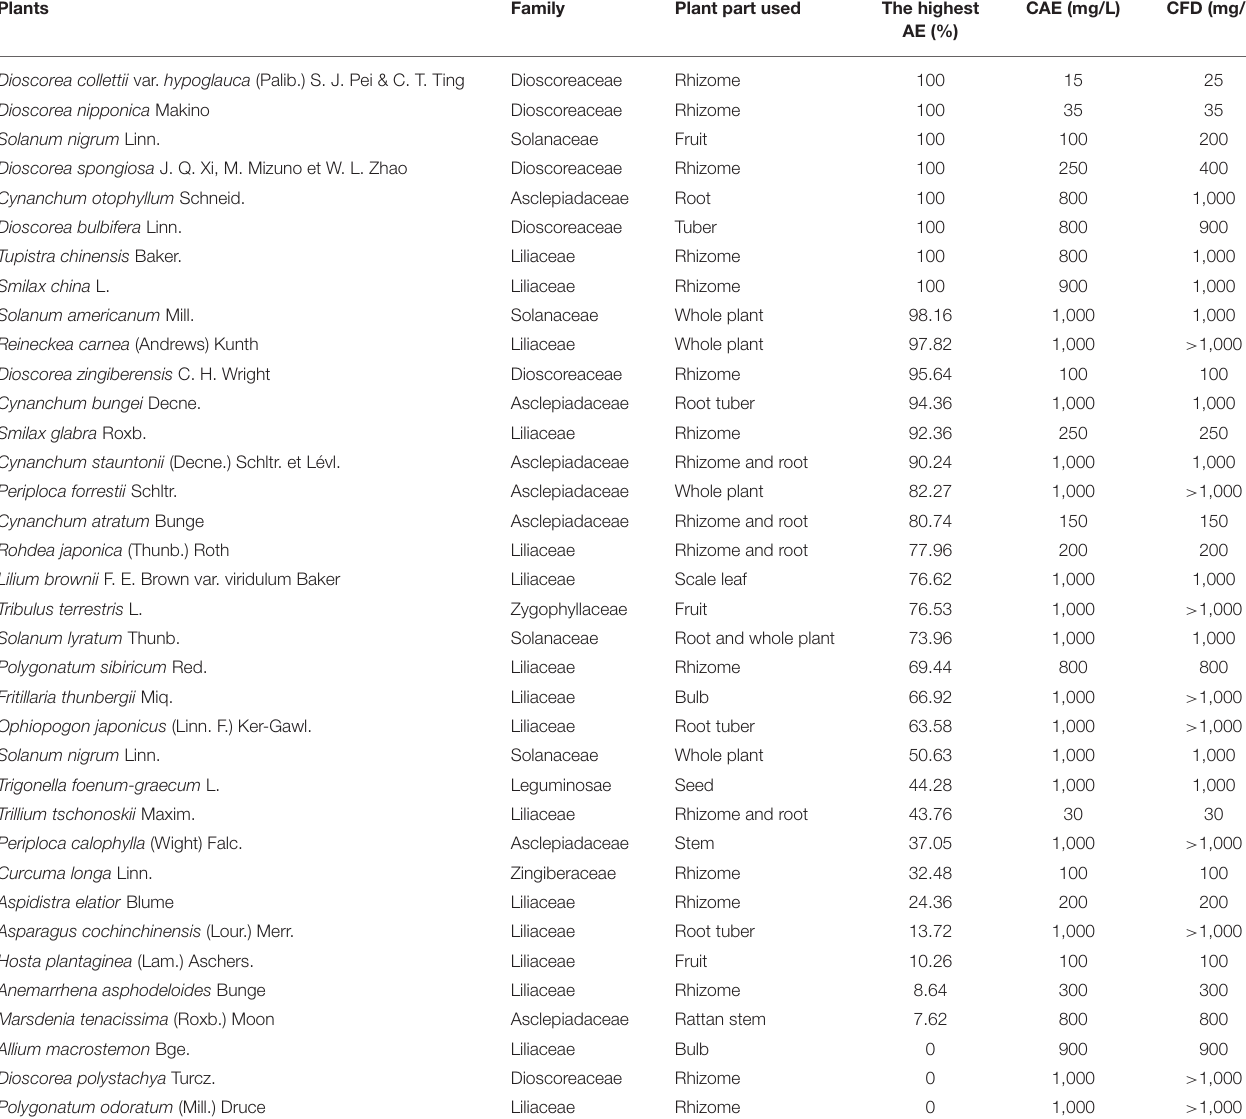
TABLE 1 | Summary of tested plants used in the trial.